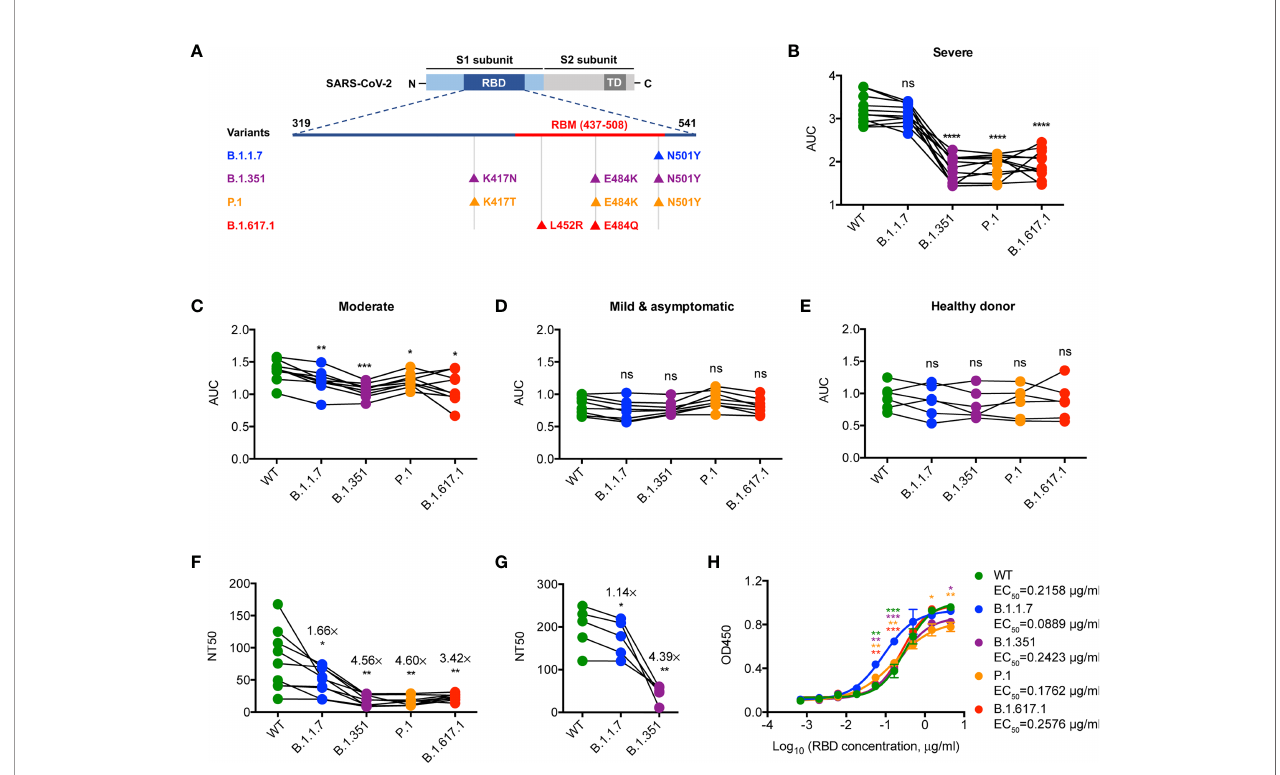
FIGURE 1 | Neutralization of SARS-CoV-2 VOCs by convalescent sera. (A) Schematic diagram showing the location of mutations of SARS-CoV-2 VOCs in the context of RBD protein domain. RBD, receptor binding domain; RBM, receptor binding motif; TD, transmembrane domain. (B – E) ELISA binding assay of COVID-19 convalescent patient sera (B – D) or healthy donor sera (E) to ELISA plate coating of RBD proteins of SARS-CoV-2 and its mutated variants as indicated. AUC, area under the curve. (F) COVID-19 convalescent patient serum-mediated inhibition of indicated RBD proteins binding to ACE2 protein by ELISA. NT50, neutralizing titer 50. (G) COVID-19 convalescent patient serum-mediated neutralization of indicated SARS-CoV-2 pseudoviruses. NT50, neutralizing titer 50. (H) ELISA binding assay of ACE2 to indicated RBD proteins. EC 50 , concentration for 50% of maximal effect. The data are representative of at least two independent experiments. * p < 0.05, ** p < 0.01, *** p < 0.001, and **** p < 0.0001. Not signi fi cant, ns. Error bars in (H) indicate